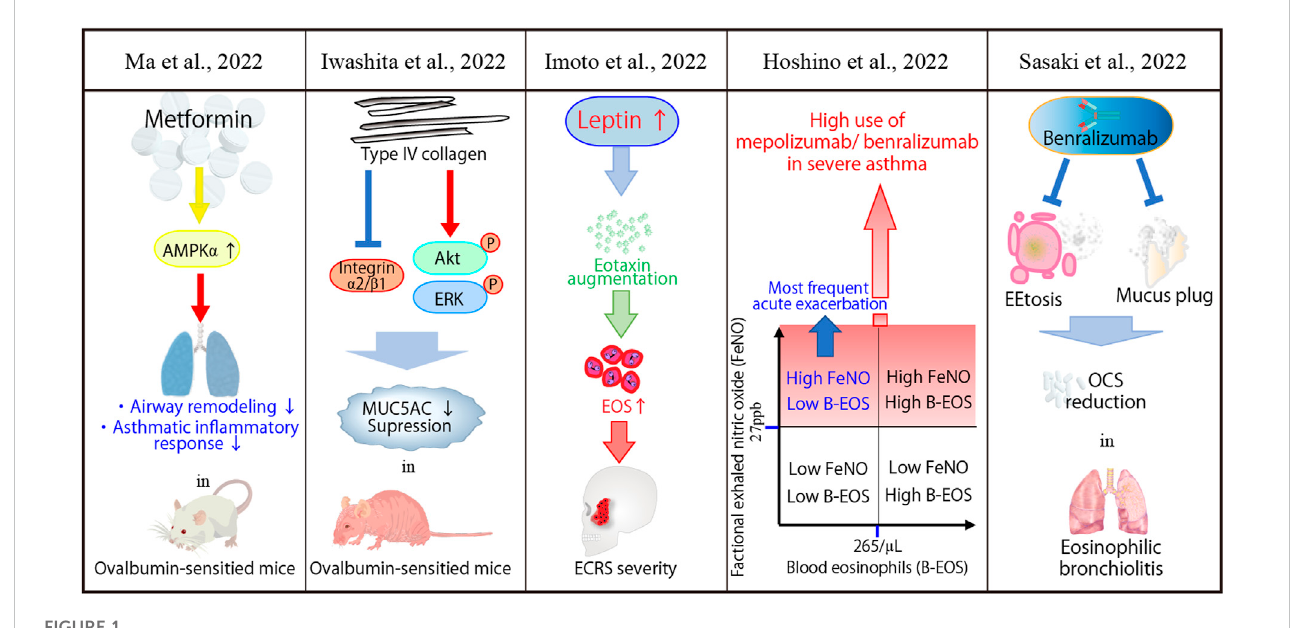
FIGURE 1 A brief summary of articles and a case report are shown.